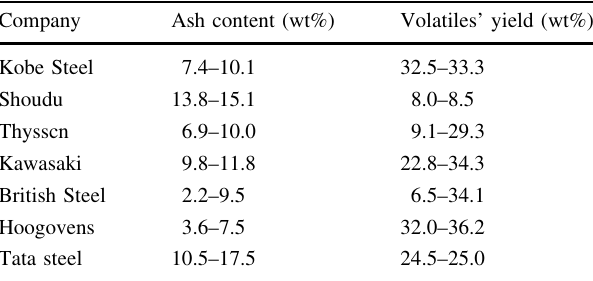
Table 4 Yield of ash content and volatiles of coal used for pulver- ized coal injection by key steel manufacturers (Hutny et al. 1991) Company